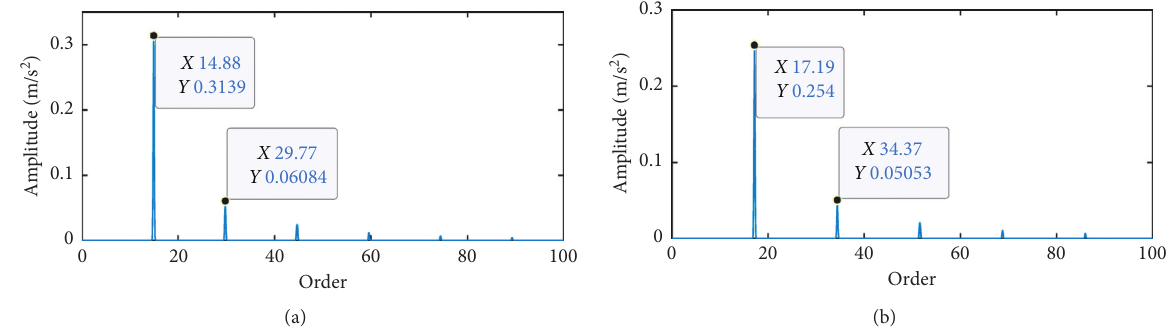
Figure 12: The envelope order spectra obtained by using (a) MCM: the spectrum is clear, and SNR2 is 33.4dB; (b) GRM: the spectrum is clear, but SNR2 is only − 44.7dB.